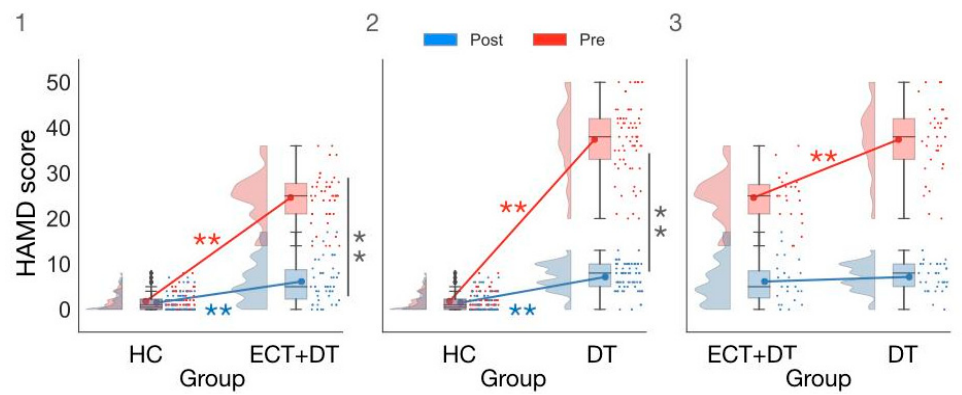
Figure 2. Comparison of HAMD scores in ( 1 ) HC vs. ECT + DT group; ( 2 ) HC vs. DT group; ( 3 ) ECT + DT vs. DT group. ** p < 0.001.